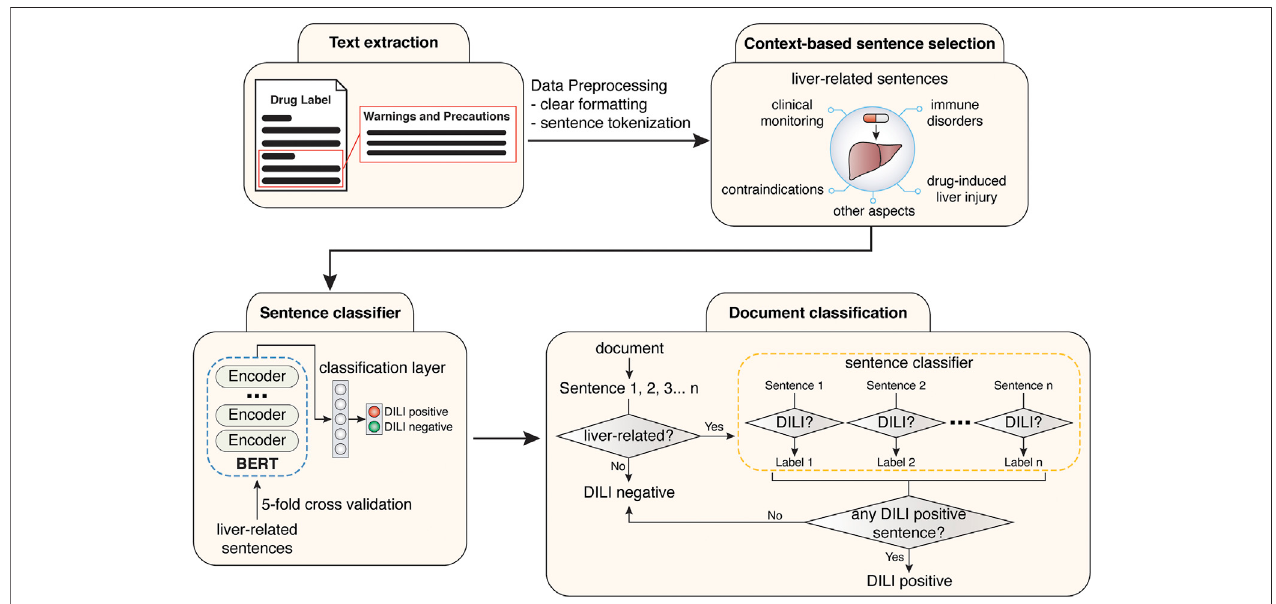
FIGURE 2 | Work fl ow for the training of sentence classi fi cation module and the development of fi nal document classi fi cation model.